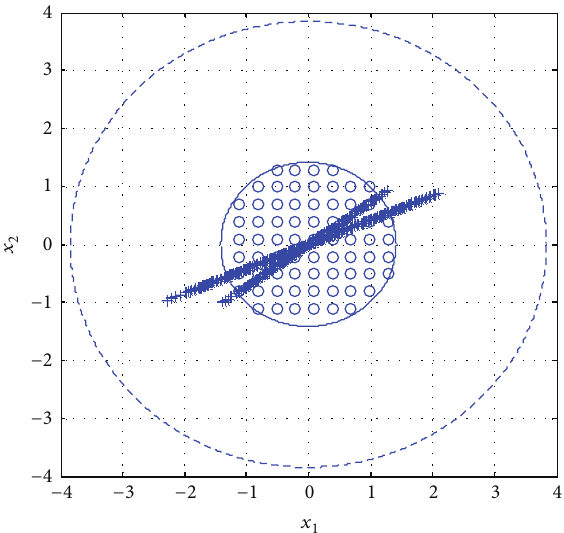
Figure 1: State response and minimum bound by Corollary 7. Figure 2: State response and minimum bound without reset con- troller.